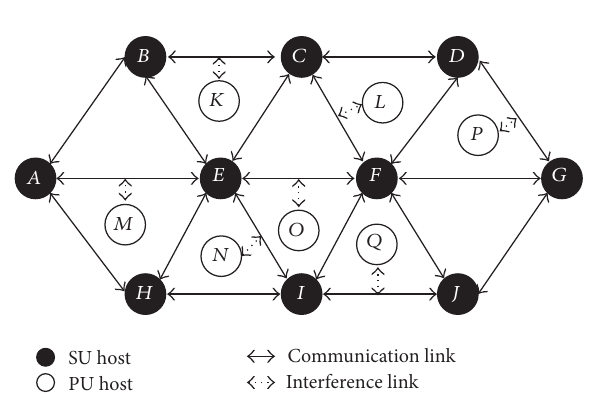
Figure 1: Network